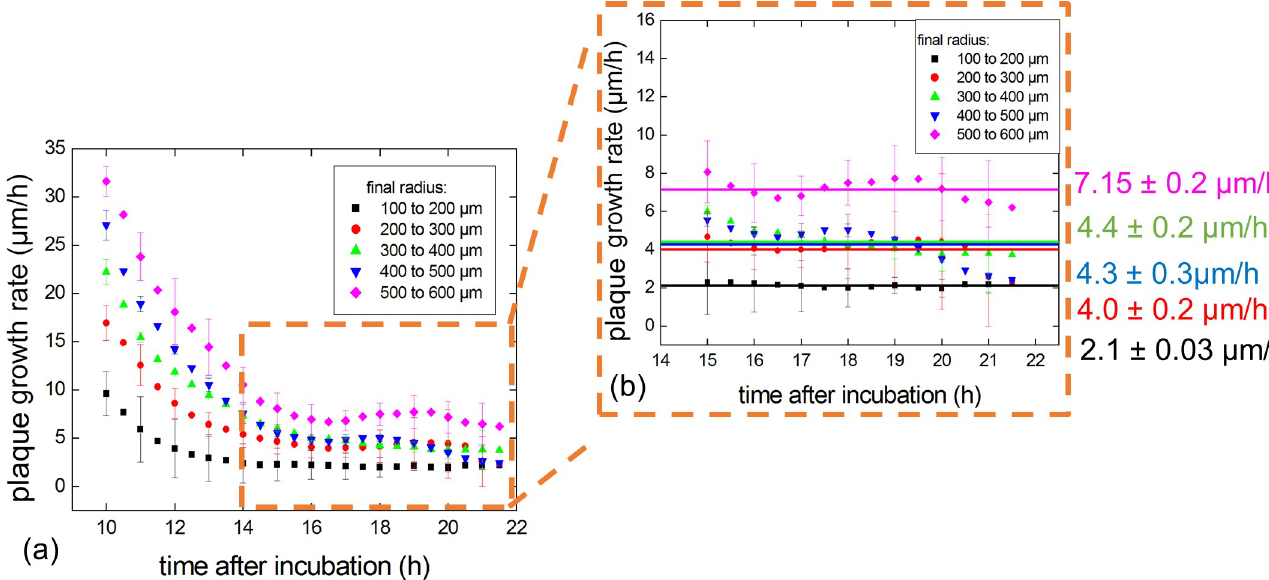
Fig 7. Study of plaque growth rates over time. Plaque growth rates vs time. (a) At 15 hr of incubation, the mean growth rate stabilized for all plaques independent of the size reached by the end of the experiment. (b) The mean growth rates during phase III were determined for each group.